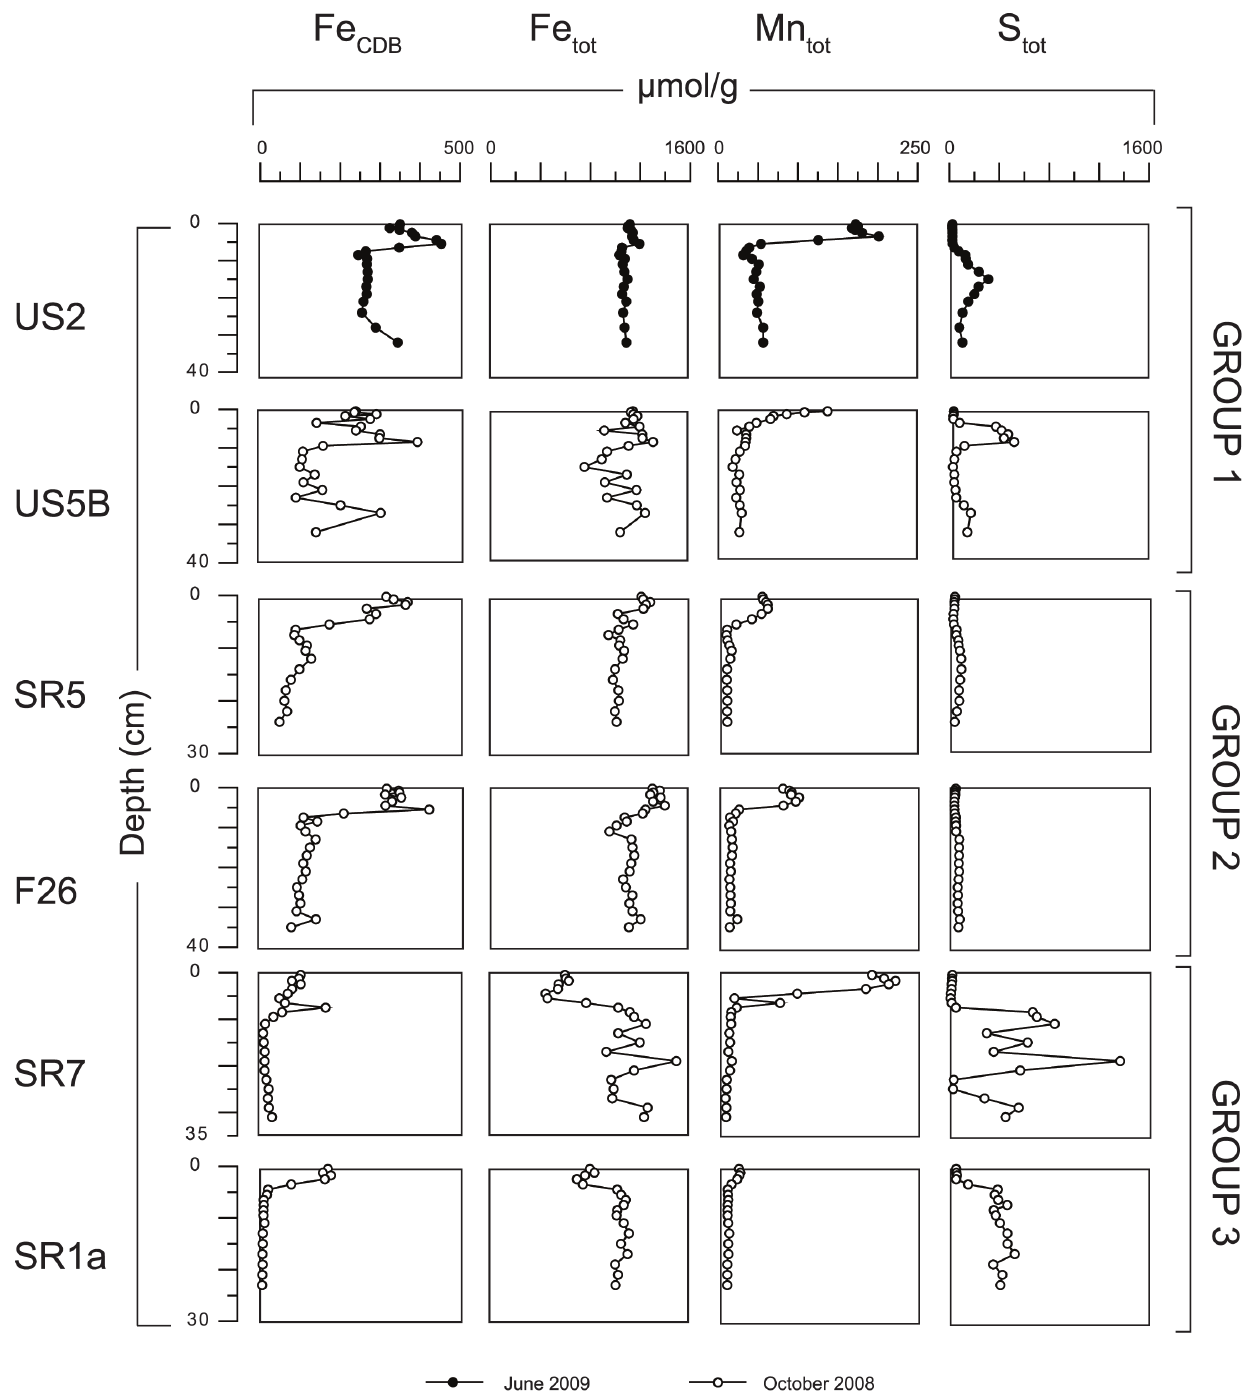
Figure 4. Sediment depth profiles of CDB Fe, total Fe, total Mn and total S (in m mol/g). CDB-Fe is typically used as a measure of total Fe- oxide Fe in the sediment but may include vivianite-Fe [33] and Fe-sulfides